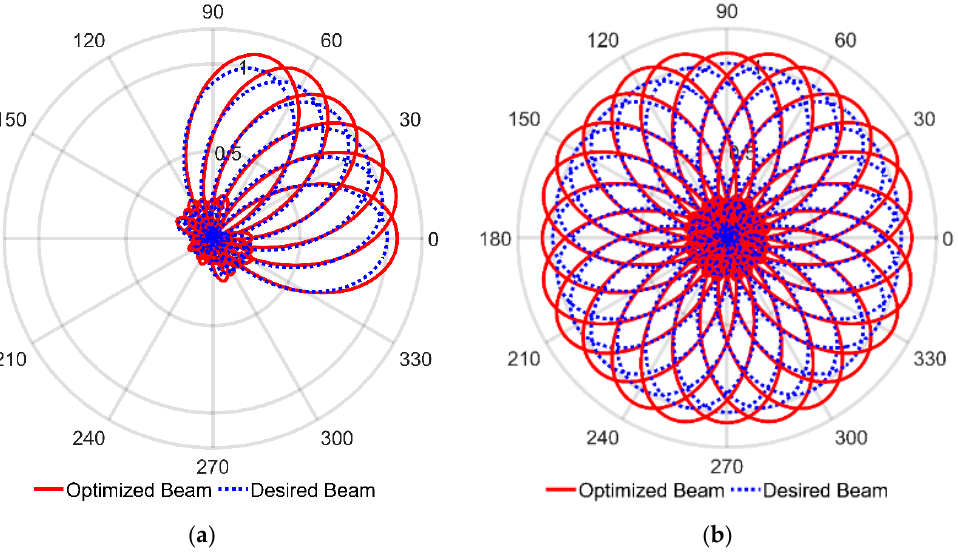
Figure 11. Beam Patterns of Two-Square Configuration 2: ( a ) Beam to 0°, 15°, 30°, 45°, 60°, and 75°, ( b ) Rotated beams.